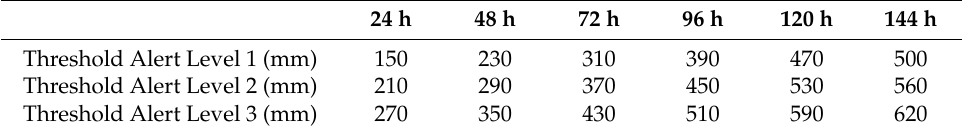
Table A1. The threshold values used in the previous version of the Extreme Rainfall Detection System.